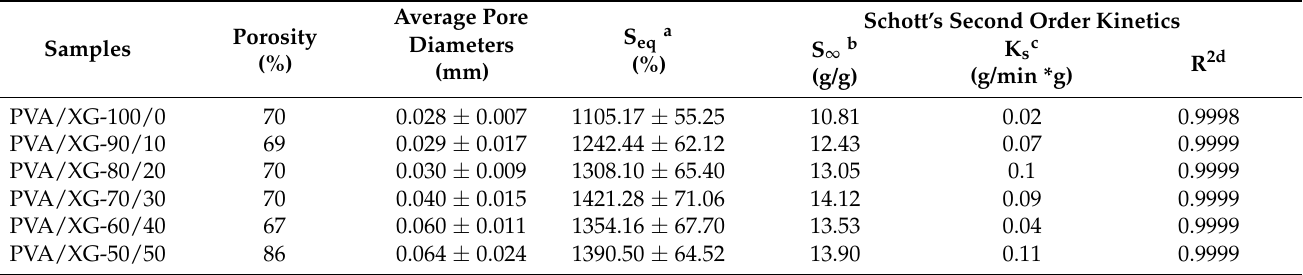
Table 2. Porosity, average pore diameters, equilibrium swelling ratio (S eq ), and swelling. Kinetics parameters for PVA/XG